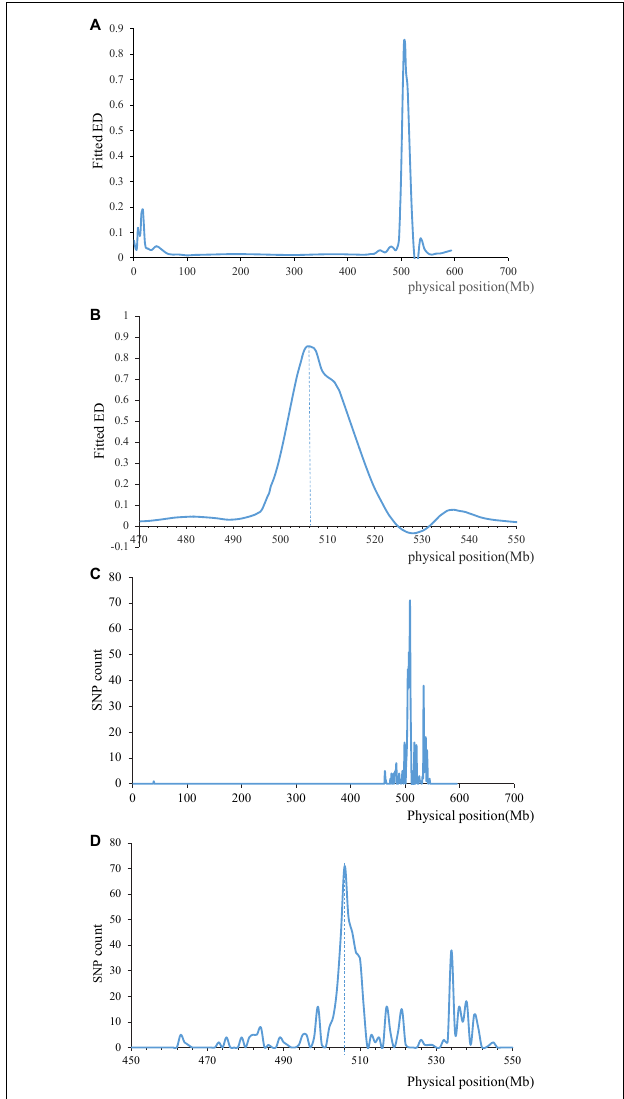
FIGURE 4 | Results of the BSE-Seq analysis method. Fitted ED on chromosome 1A (A) and ED after zooming in the area near the maximum (B) . SNP count between R bulk same as Pascal and S bulk same as Huixianhong on chromosome 1A (C) , and SNP count after zooming in the area near the maximum (D)